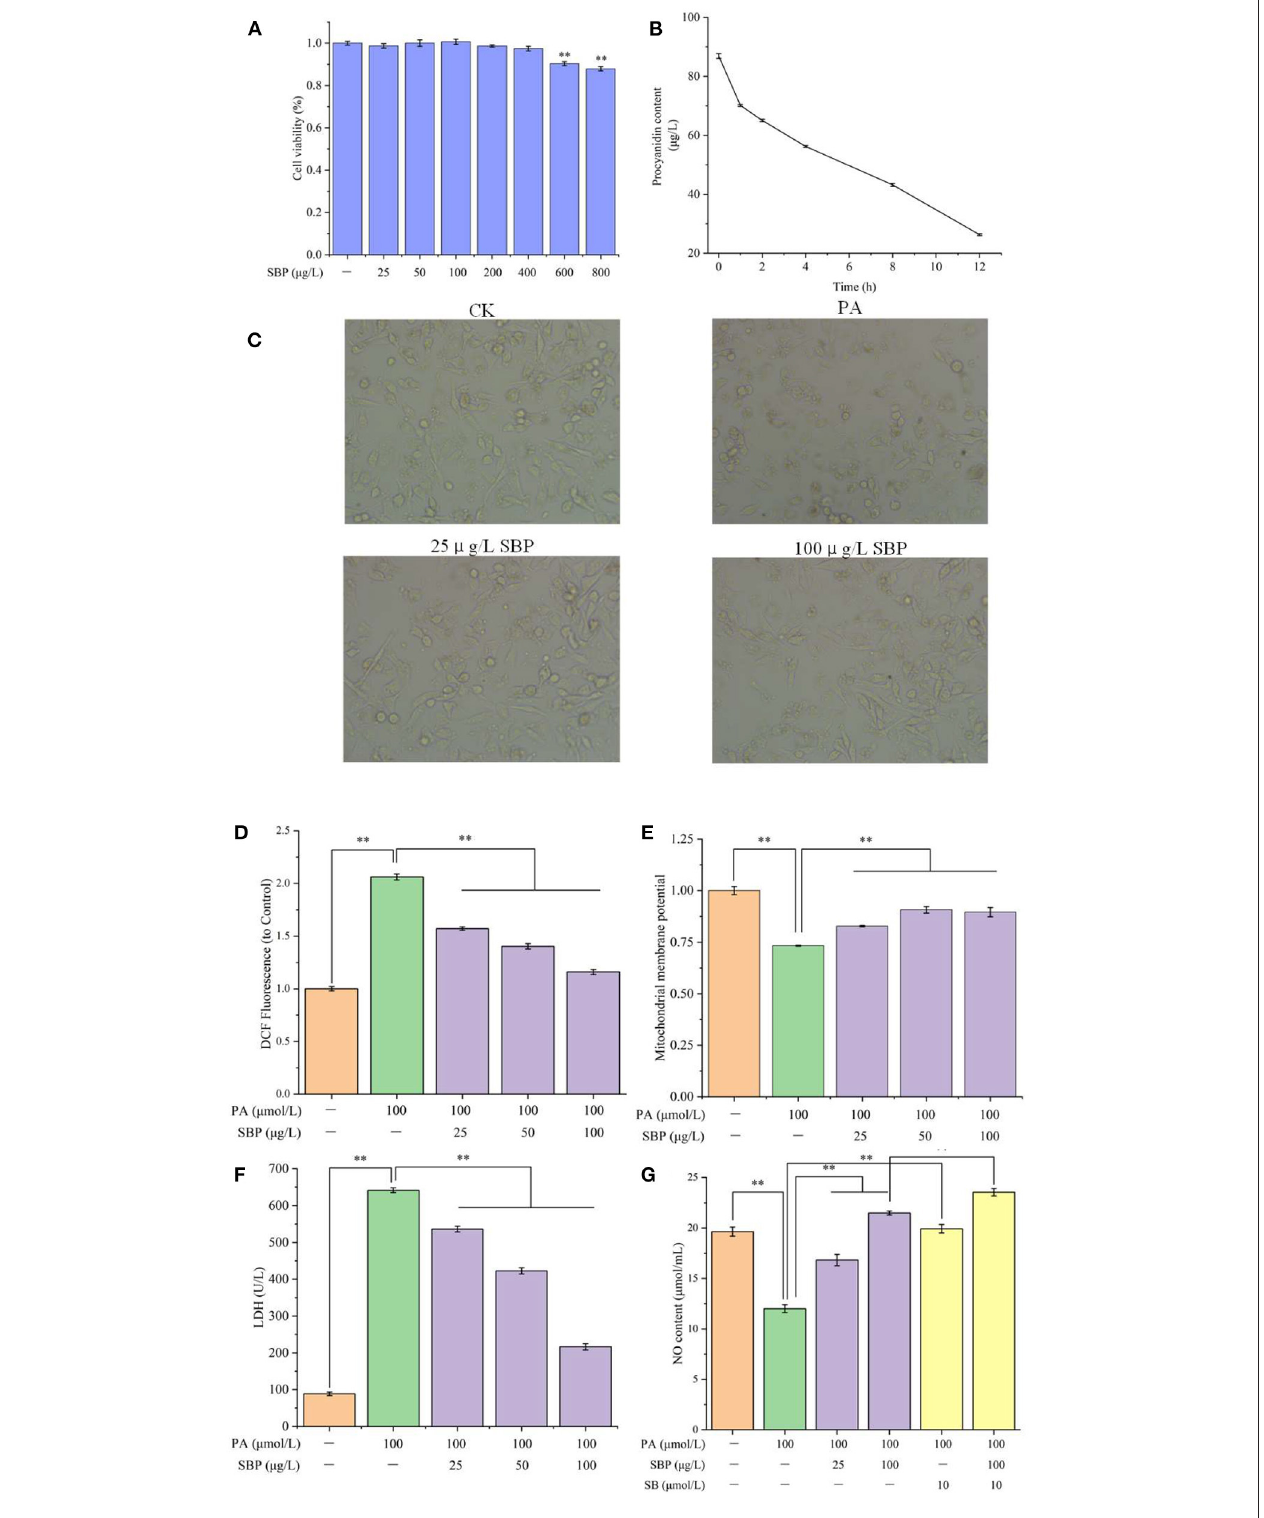
FIGURE 1 | Cell viability of HUVECs with different concentrations of SBP (A) , SBP absorption in HUVECs (B) , HUVECs cellular morphology under different treatments (C) , Mitochondrial membrane potential of different treatments (D) , LDH leakage of different treatments (E) , NO content of different treatments (F) , ROS content of different treatments (G) . The results were expressed as the mean ± SD ( n = 5). ** p < 0.01.